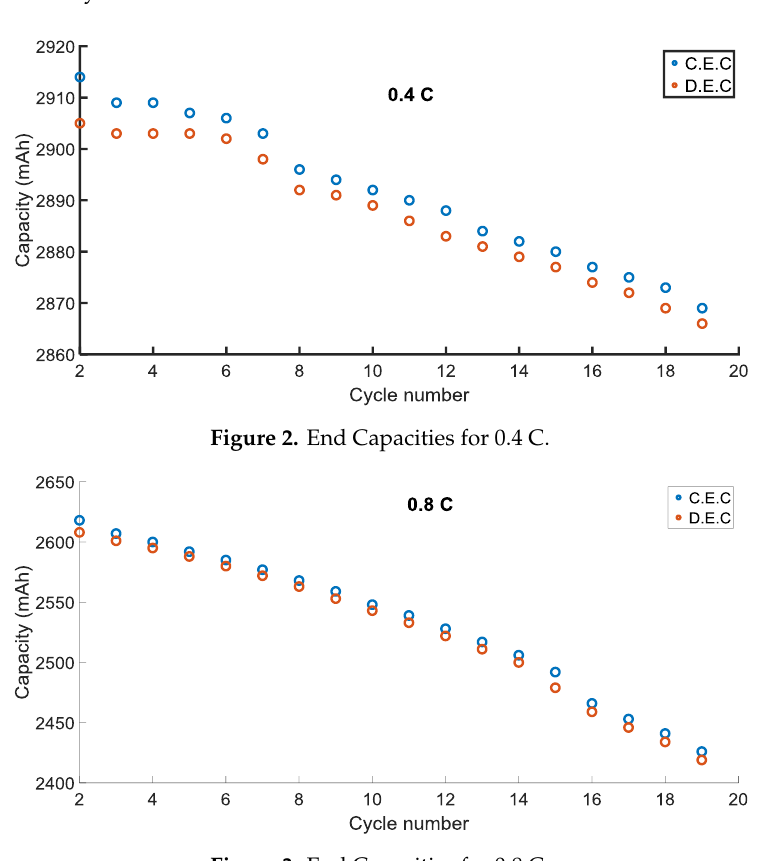
Figure 3. End Capacities for 0.8 C.